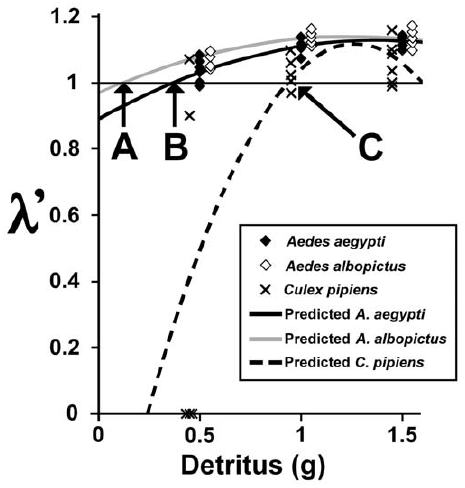
Figure 2. Experimental response of mean l 9 for each species by detritus amounts. Data points for A. albopictus and C. pipiens are offset. The curves represent the quadratic function for each species, while the arrows indicate values of x at which l 9 =1.0 (R Index ) for A. albopictus ( A ), A. aegypti ( B ), and C. pipiens ( C ).